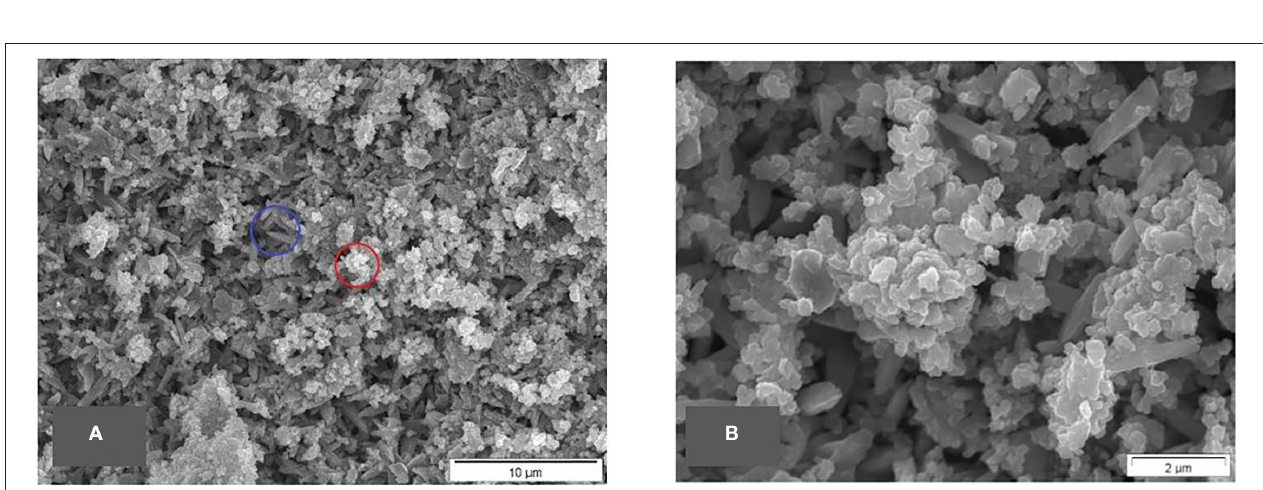
FIGURE 3 | (A,B) SEM micrographs of calcined raw materials/washed common horsetail, typical silica structure highlighted by a red circle, structures from other material highlighted by a blue circle.